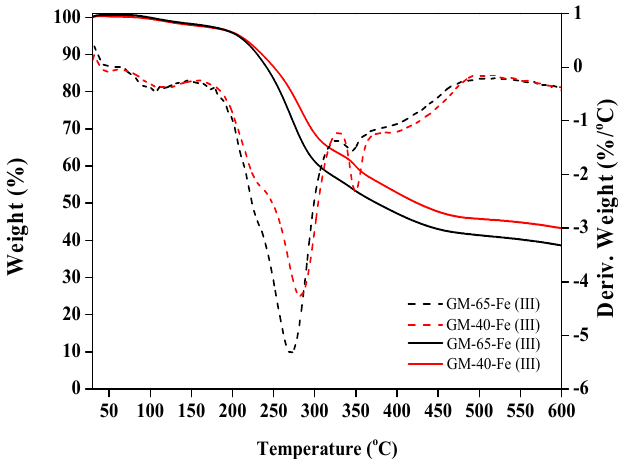
Figure 5. Thermogravimetric (TG) curves and derivative weight (DTG) curves of the galactomannan– iron(III) complexes.